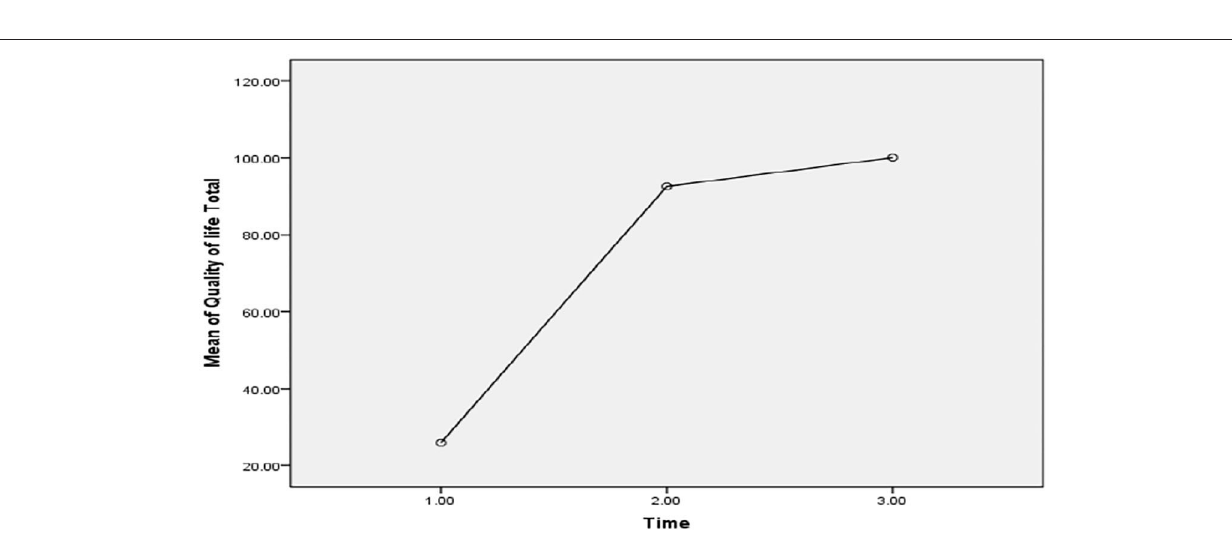
FIGURE 10 | Illustrative mean difference of quality of life between the pretesting phase (T-0), posttesting phase (T-1), and follow-up phase (T-2) in Pakistan students during the COVID-19 epidemic lockdown ( N =